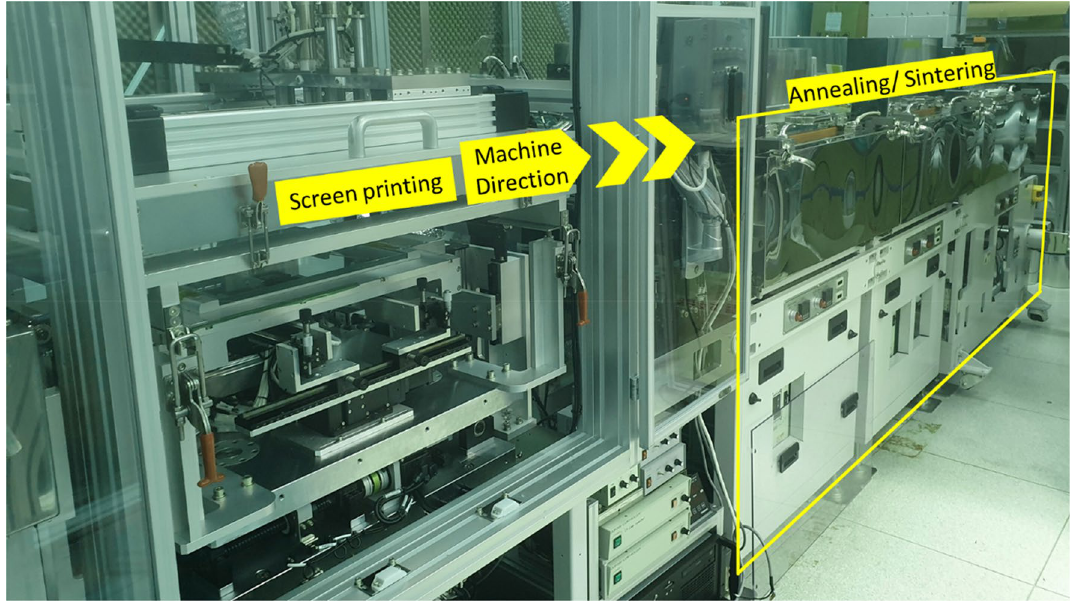
Figure 10. R2R Screen printing system used in the